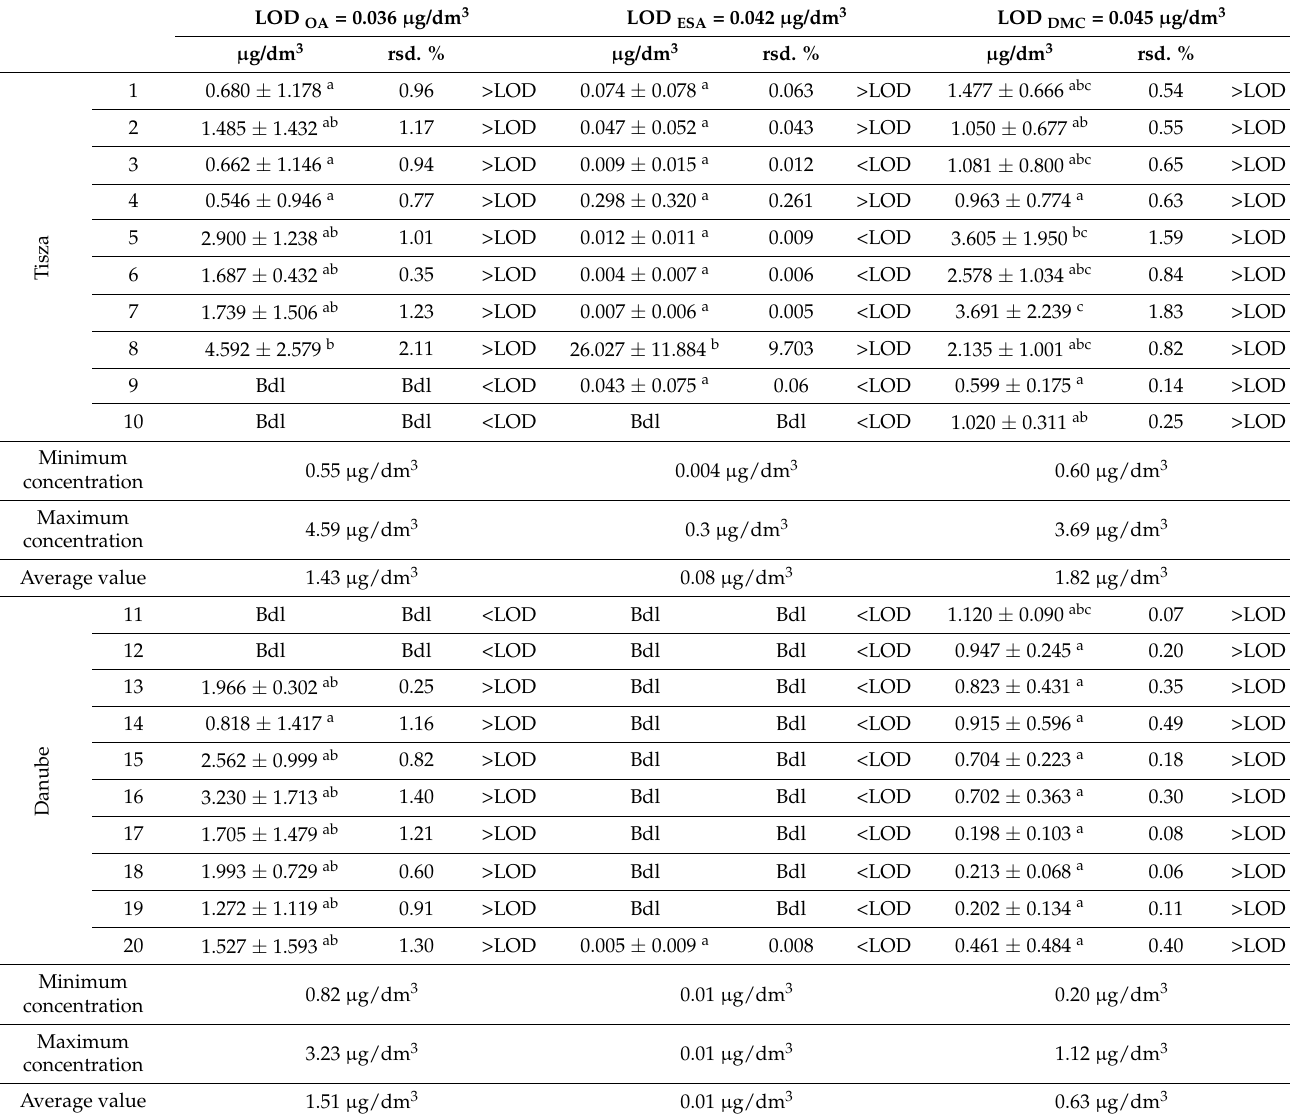
Table 9. Summary of DMC, ESA and OA concentrations detected in water samples from sampling sites in the Danube River and the Tisza